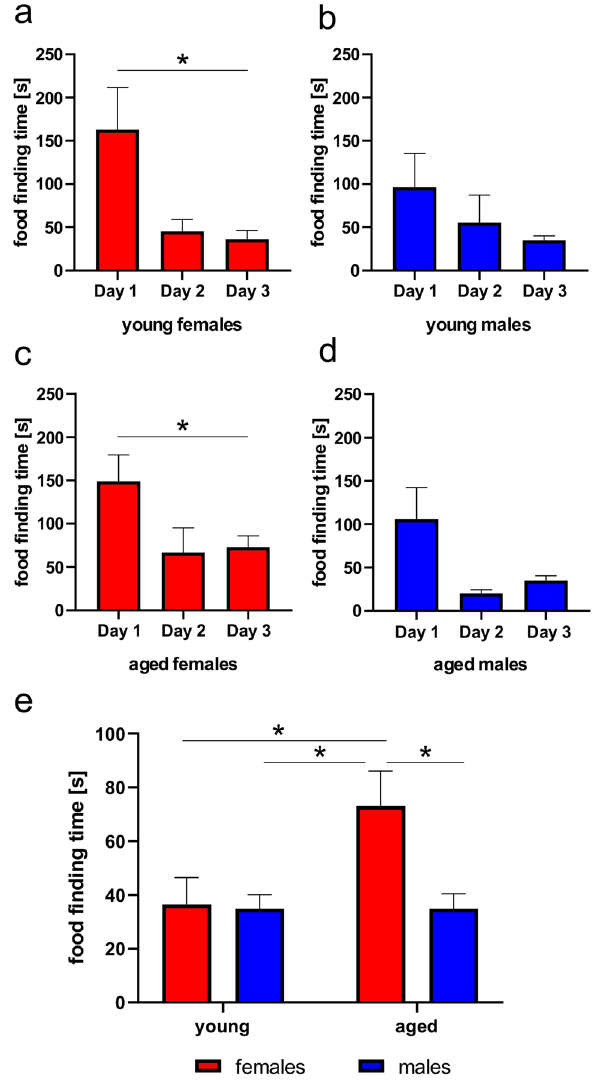
Figure 2. Performance of opossums in olfactory-guided test. ( a – d ) Time for food location during the first trail of day 1, the first trail of day 2 and testing day 3. Quantification of time to digging in the place with orange odorant where a piece of orange was previously